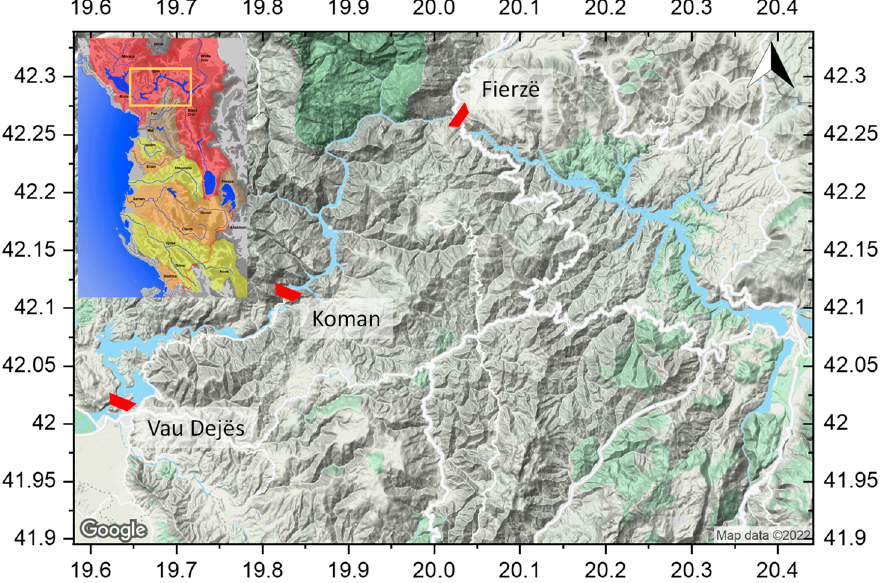
Figure 1. Location of the Drin River Cascade HPPs.